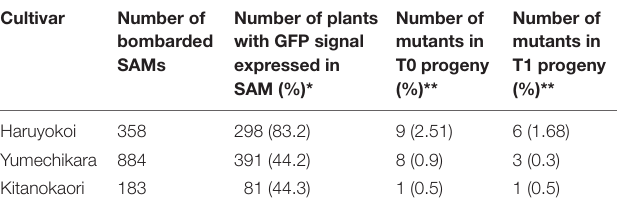
FIGURE 4 | Effect of mutation of Haruyokoi TaQsd1 in seed dormancy. (A) Germination of H2-8-6 mutant seeds on a Petri dish at 22 ◦ C in the dark. The photo was taken after 2-weeks from the beginning of the experiment. (B) The germination rate of WT and H2-8-6 in 30 days. Five biological replicates and 120 seeds in each replicate were used in this experiment.